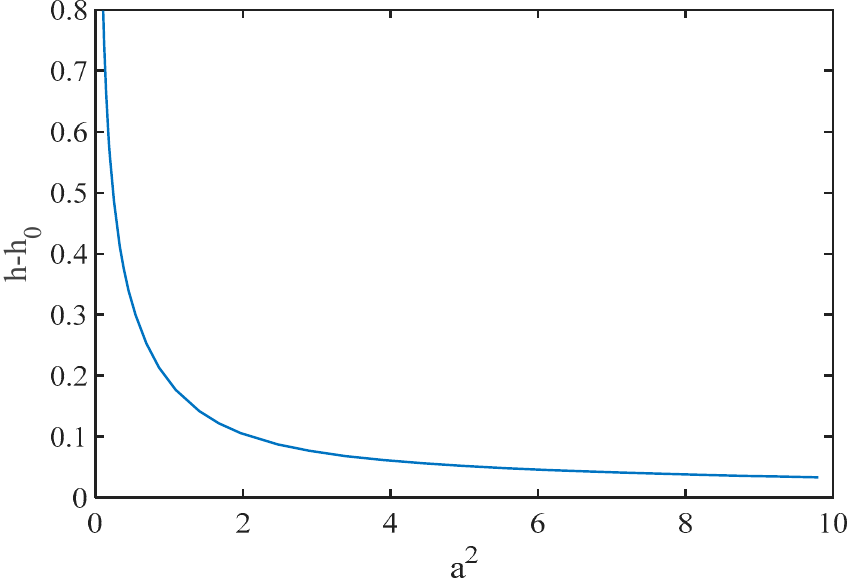
Figure 3. The maximum upper layer thickness changes ( h − h 0 at t = 1 ) as a function of a 2 . This result is digitized from the numerical solutions of Equation (2), as presented by Broström [15] (Reprinted with permission from Ref. [15]. 2008, Elsevier).